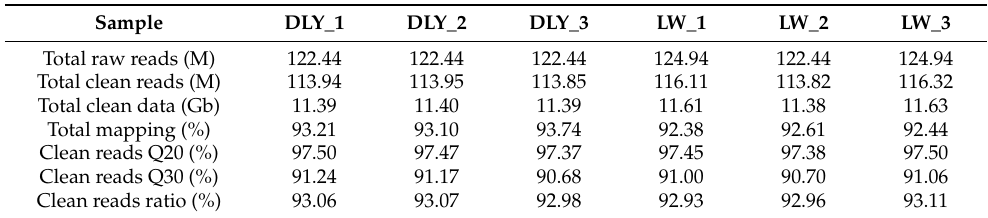
Figure 1. Sample description of the Longissimus dorsi muscle from Duroc × Landrace × Yorkshire (DLY) and Laiwu (LW) pigs. Differences in the live weight ( A ) and intramuscular fat content (IMF) ( B ) in the Longissimus dorsi (LD) muscles between LW and DLY pigs. * p < 0.05. ( C ) Representative images of ORO staining in Longissimus dorsi of DLY and LW pigs (Scale bars, 100 µ m). n = 3 biological samples. ( D ) Immunohistochemical localization of F59 and S46 in Longissimus dorsi of DLY and LW pigs (Scale bars, 100 µ m). n = 3 biological samples. Table 1. Statistics of cDNA libraries of mRNA and lncRNA of Longissimus dorsi muscle samples from LW and DLY pigs.